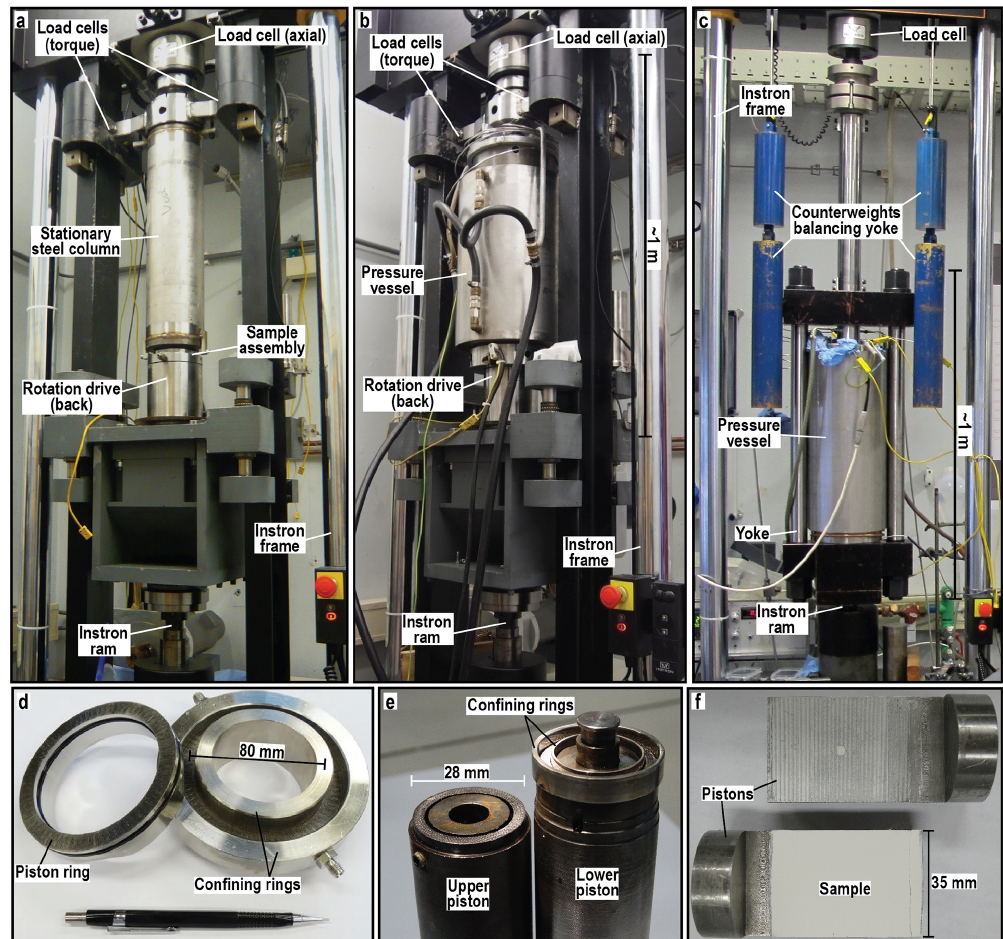
Figure 2. Apparatuses and testing assemblies used for low-velocity, ring- and direct-shear friction experiments at UU. (a, b) The room- temperature ring-shear set-up. (b, e) The hydrothermal ring-shear set-up. (c, f) The direct-shear set-up using a triaxial pressure cell (in this case the “shuttle vessel”). Photo (a) courtesy of Miki Takahashi (Geological Survey of Japan). Photo (d) taken with publishers’ permission from Van den Ende and Niemeijer